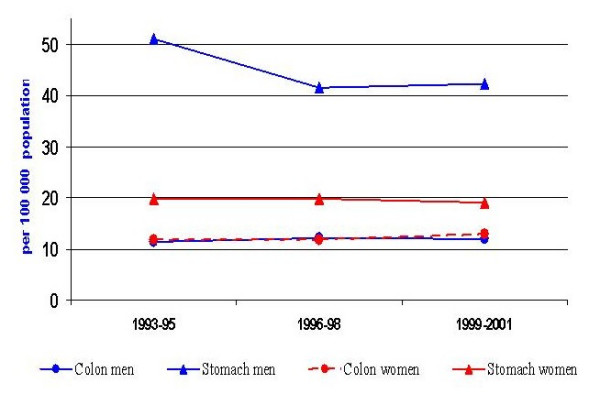
Trend of age-adjusted colon and stomach cancer among men and women in Arkhangelskaja Oblast.